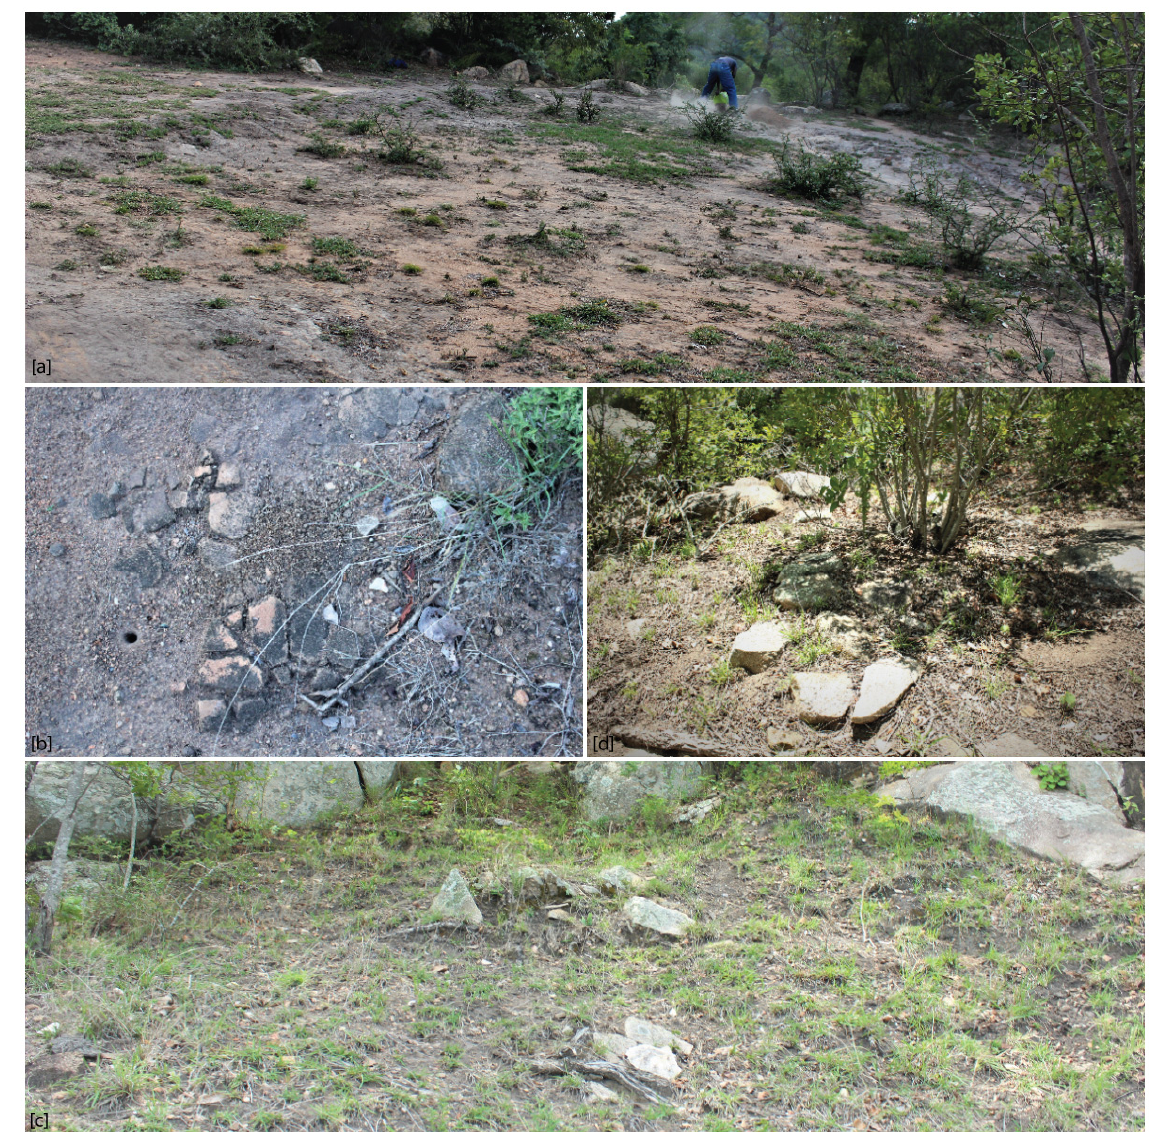
Figure 7. ( a ) Section of large kraal with vitrified dung situated on the northern end of Chumnungwa foothill, ( b ) dhaka fragments of housing recorded at Chumnungwa, ( c ) large ashy midden with visible scatters of potsherds, slag, bone, and charcoal spread on the south ‐ eastern section of the Chumnungwa hilltop, ( d ) remnants of a grain bin foundation recorded at Chumnungwa.